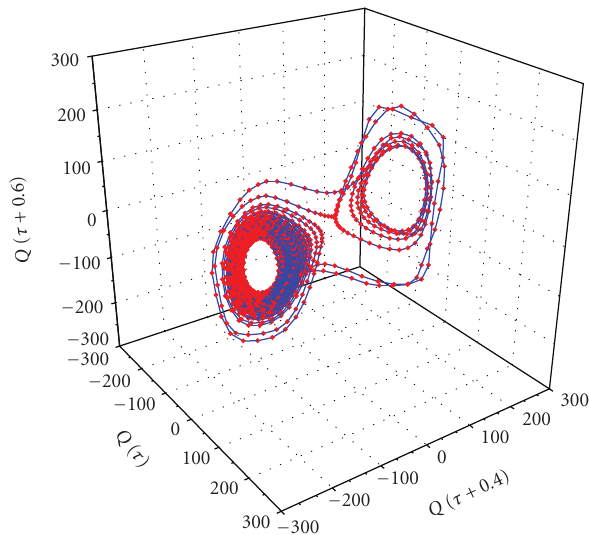
Figure 12: Lorenz-like attractor; Ra = 48 000, R = 1 . 4, and Pr = 5.